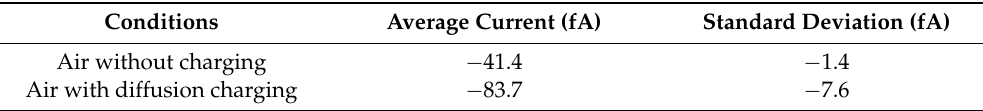
Table 1. The initial parameters for the aerosol sensor.